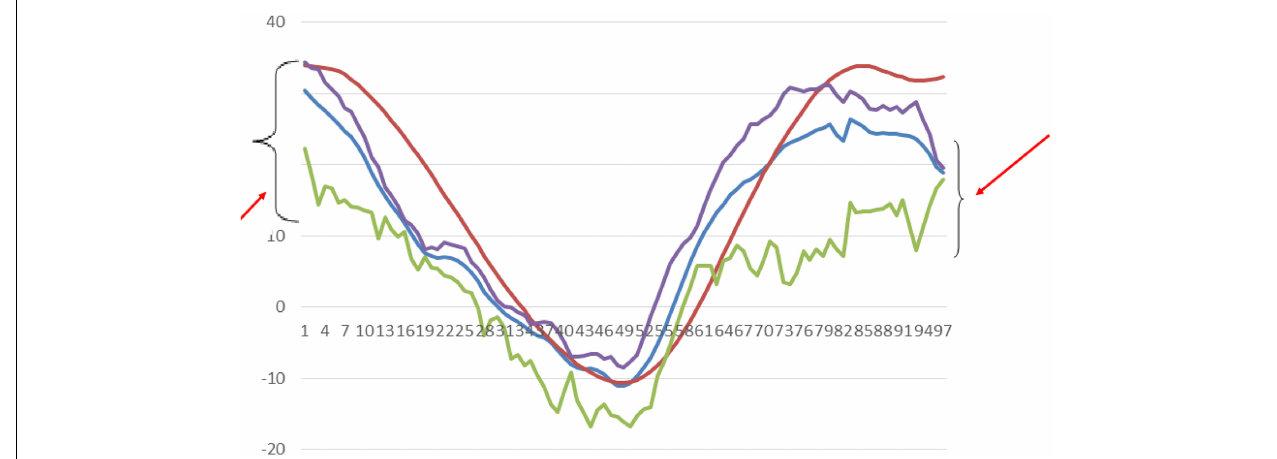
FIGURE 8 | Showing (red arrows) variations at the start and end of gait cycles in our subjects.